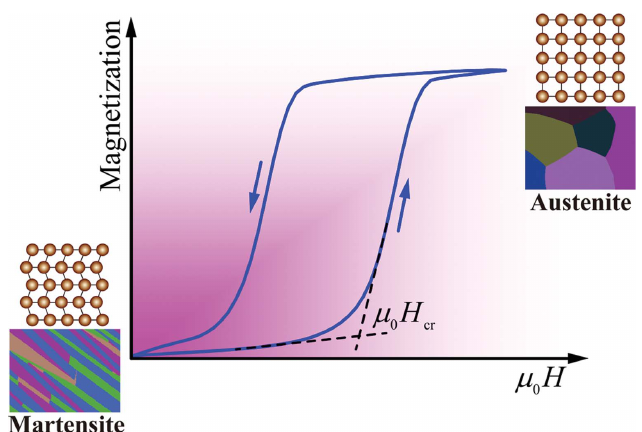
Figure 1 Illustration of field-up and field-down isothermal magnetization curves showing the reversible magnetic-field-induced magnetostructural trans- formation between weak magnetic martensite and ferromagnetic austenite in Ni–Mn– X